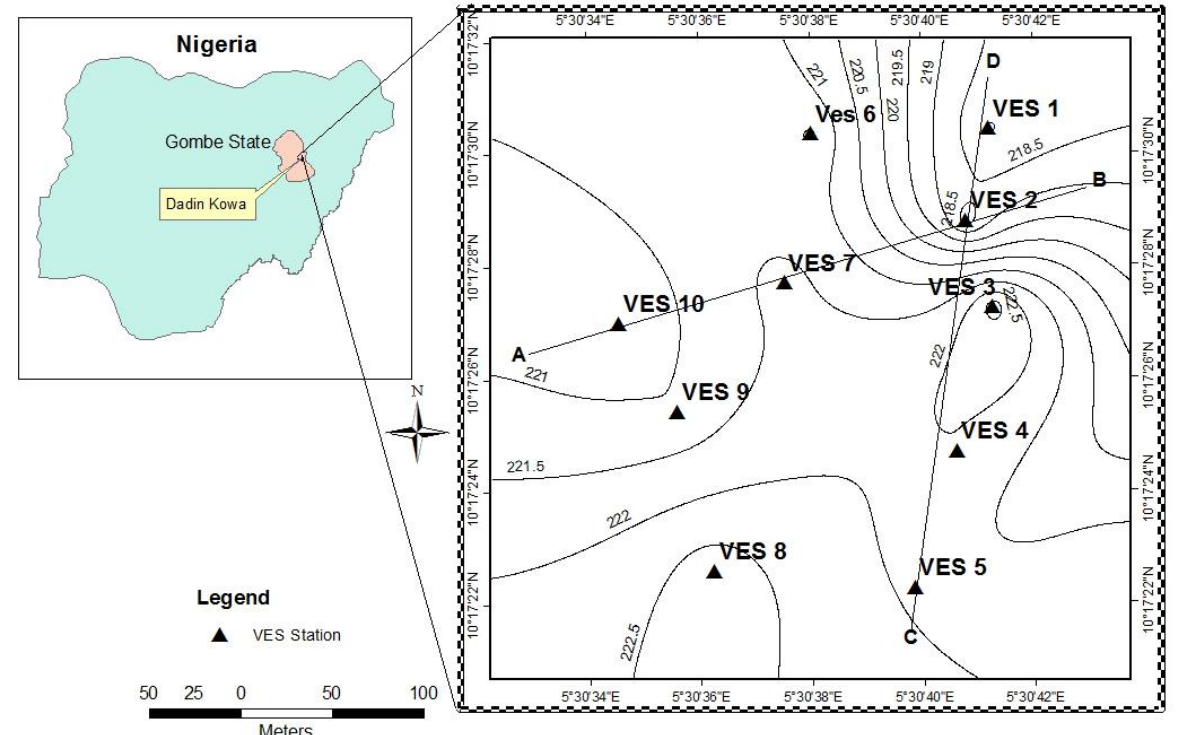
Fig. 1. Topographic of the study area showing VES locations on the